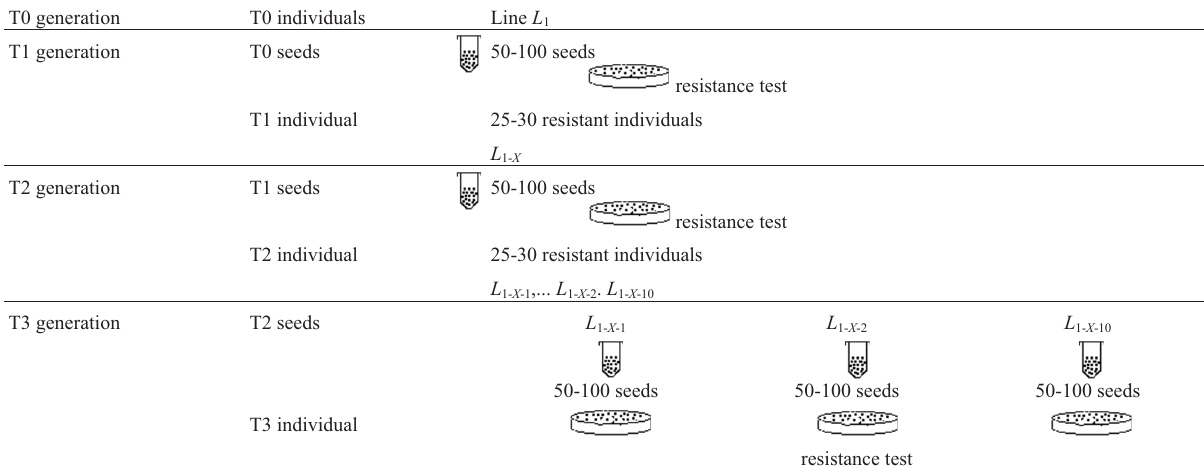
Table 1 - Experimental